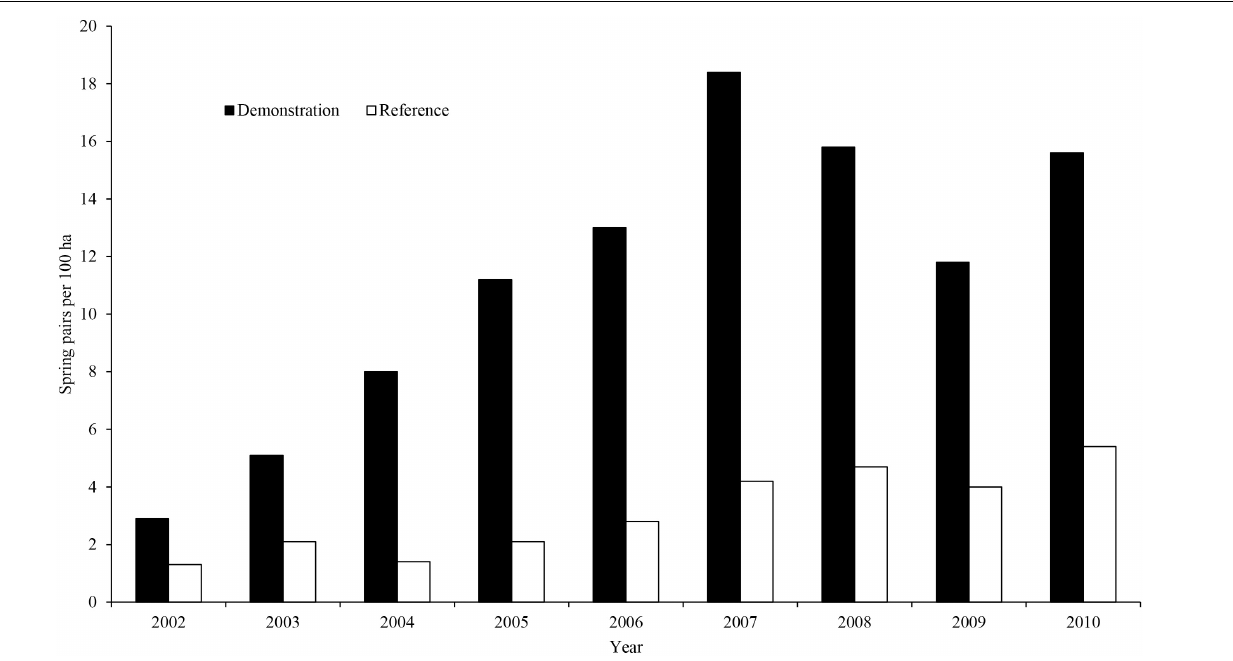
FIGURE 2 | Spring pair counts (pairs/100 ha) of gray partridges, on the GWCT’s Royston demonstration and reference areas 2002–2010. Filled bars are from the demonstration area specifically managed for gray partridges, open bars from the reference area not subjected to gray partridge-specific management.